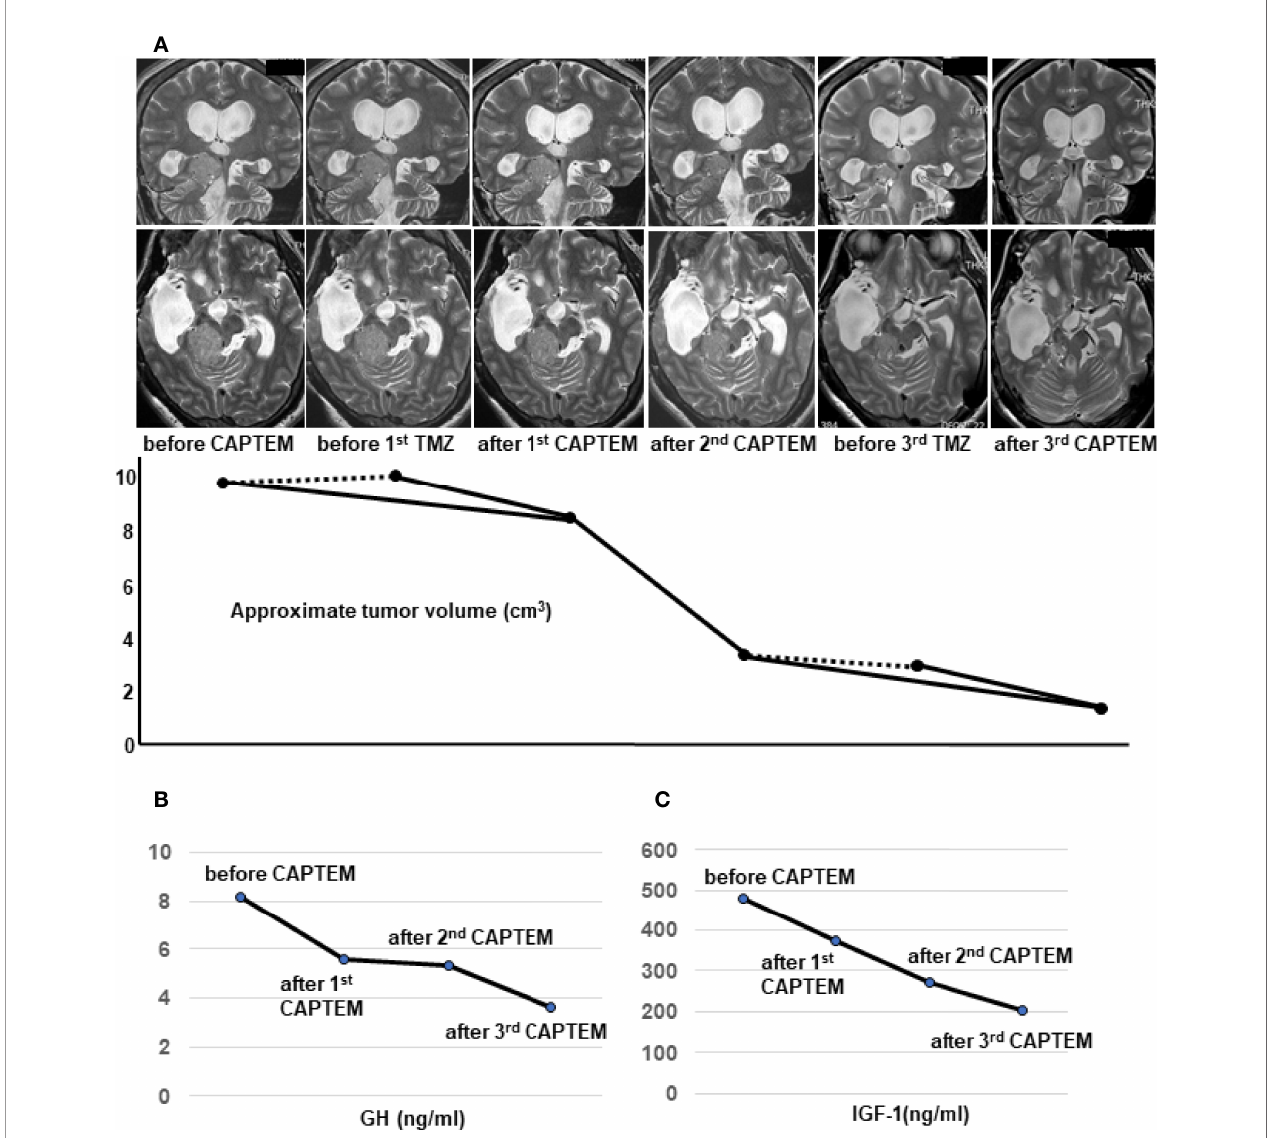
FIGURE 3 | Temozolomide and capecitabine (CAPTEM) had a signi fi cant effect on reduction of the tumor volume and serum levels of growth hormone (GH) and insulin-like growth factor (IGF-1). Thin-slices of plain T2 images were used to show the dramatic changes of the tumor volume by CAPTEM treatment (A) . The upper row shows coronal images and the lower row shows axial images (A) . Two orthogonal diameters of the tumor were measured in the coronal and axial T2-weighted images. The average of the 4 diameters was assumed as the diameter of an approximated sphere. Then, the formula of a sphere volume; 4/3 p r 3 was used to calculate the approximate tumor volume (A) . MRI just before TMZ administration did not show the volume reduction (dotted lines) but MRI just after TMZ showed considerable shrinkage (solid lines) (A) . CAPTEM had a signi fi cant effect on reduction of morning serum GH (B) and IGF-1 (C) levels. IGF-1 normal range for the patient ’ s age and sex is 78-213